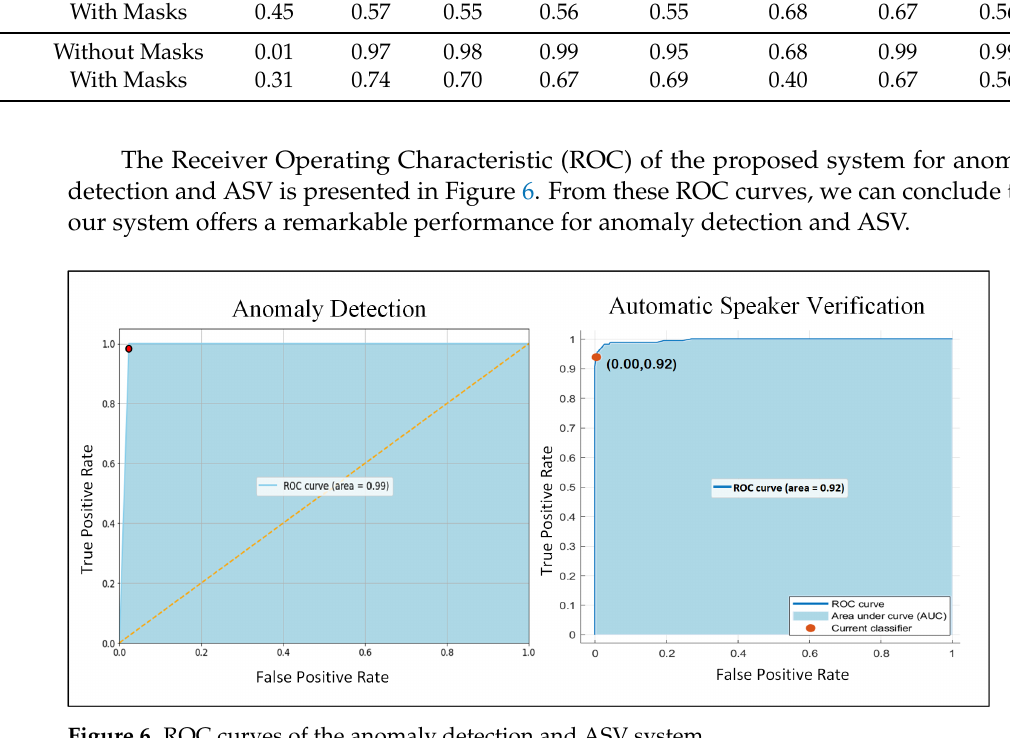
Figure 6. ROC curves of the anomaly detection and ASV